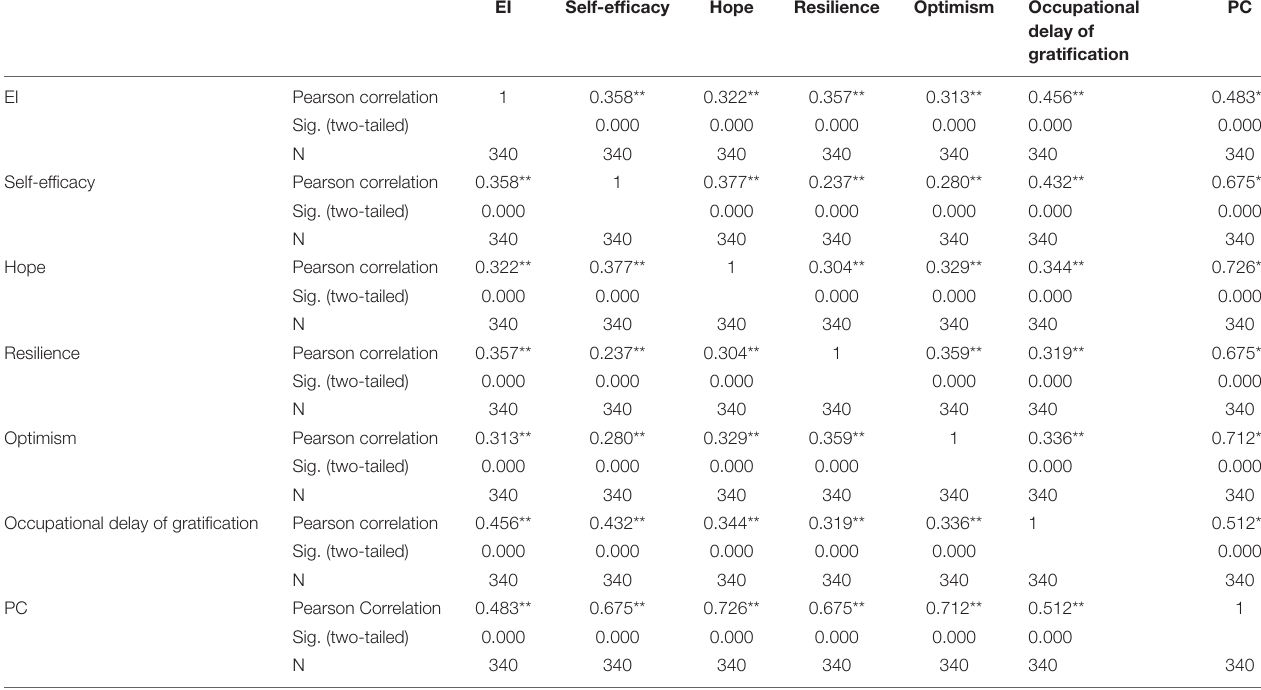
TABLE 7 | Correlations.